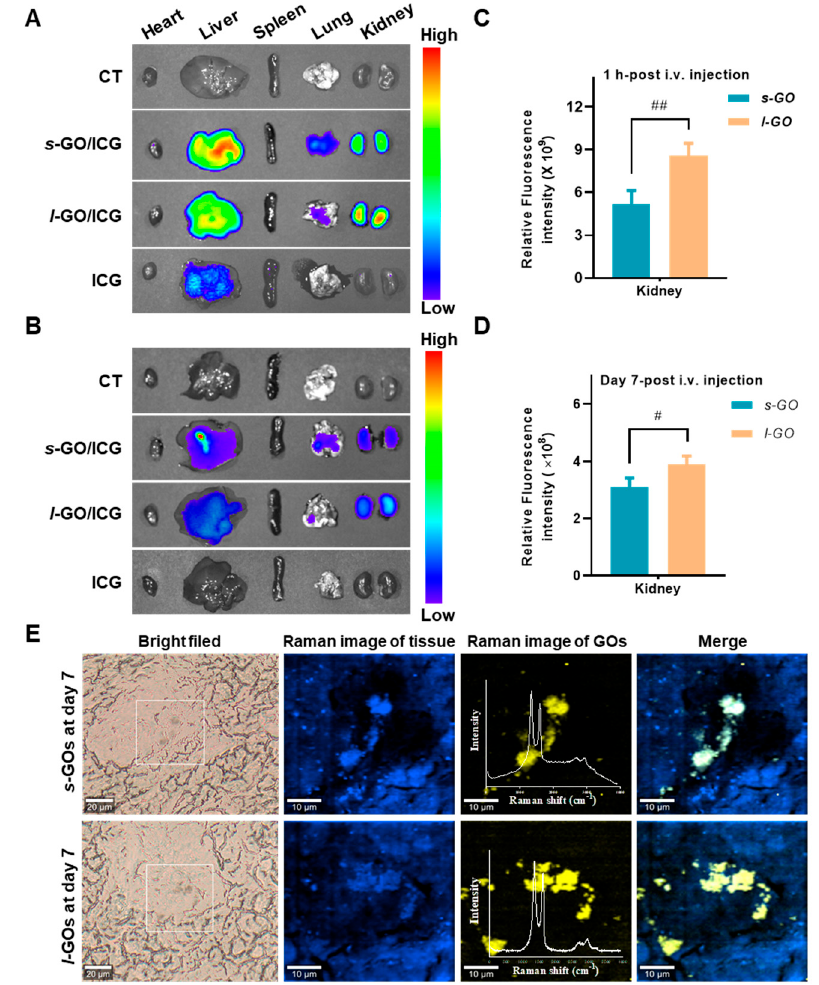
Figure 2. Representative ex vivo fluorescence images of heart, liver, spleen, lung, and kidneys at 1 h ( A ) and day 7 ( B ) after i.v. injection of s ‐ GO/ICG and l ‐ GO/ICG at 5 mg/kg bw dosage. Quantitative analysis of fluorescence intensity of GO/ICG in kidney at 1 h ( C ) and day 7 ( D ) after i.v. injection. The unit of average radiant efficiency ([p/s/cm 2 /sr]/[ μ w/cm 2 ]) is the ratio of the radiant flux of the emitted radiation to the power consumed by the source. # p < 0.05, ## p < 0.01 for s ‐ GO − vs. l ‐ GO − treated group. ( E ) Confocal Raman images show GOs deposited in the renal cortex after 7 days of the i.v. injection of 15 mg/kg bw s ‐ GOs and l ‐ GOs. From left to right: Bright field (BF) image; Raman image (RI) of kidney tissue (blue color); Raman spectrum analysis shows the characteristic D and G bands of GOs (yellow color) in the renal cortex; merge image of tissue and GOs.